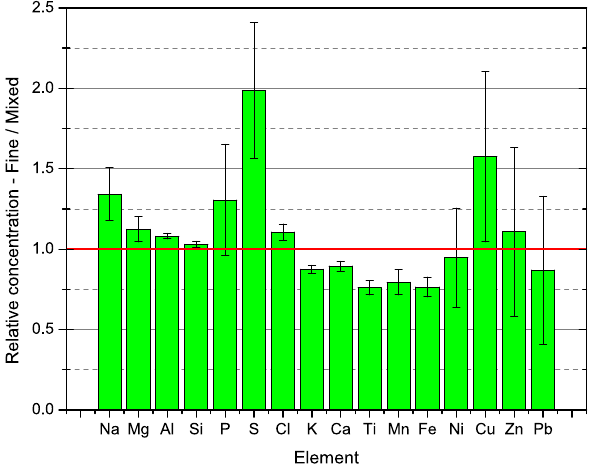
Figure 12. Relative mass concentration between fine and mixed modes. The error bars were calculated from direct error propagation from the measurement of concentrations.